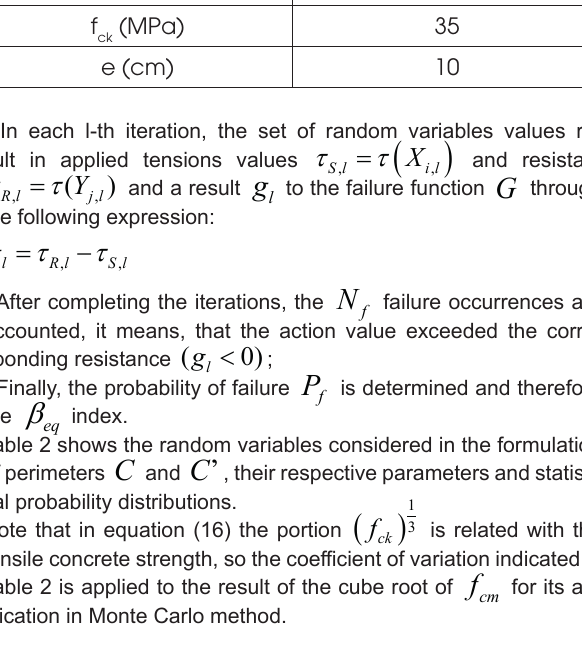
for circular column considering the variation of the slab eq β